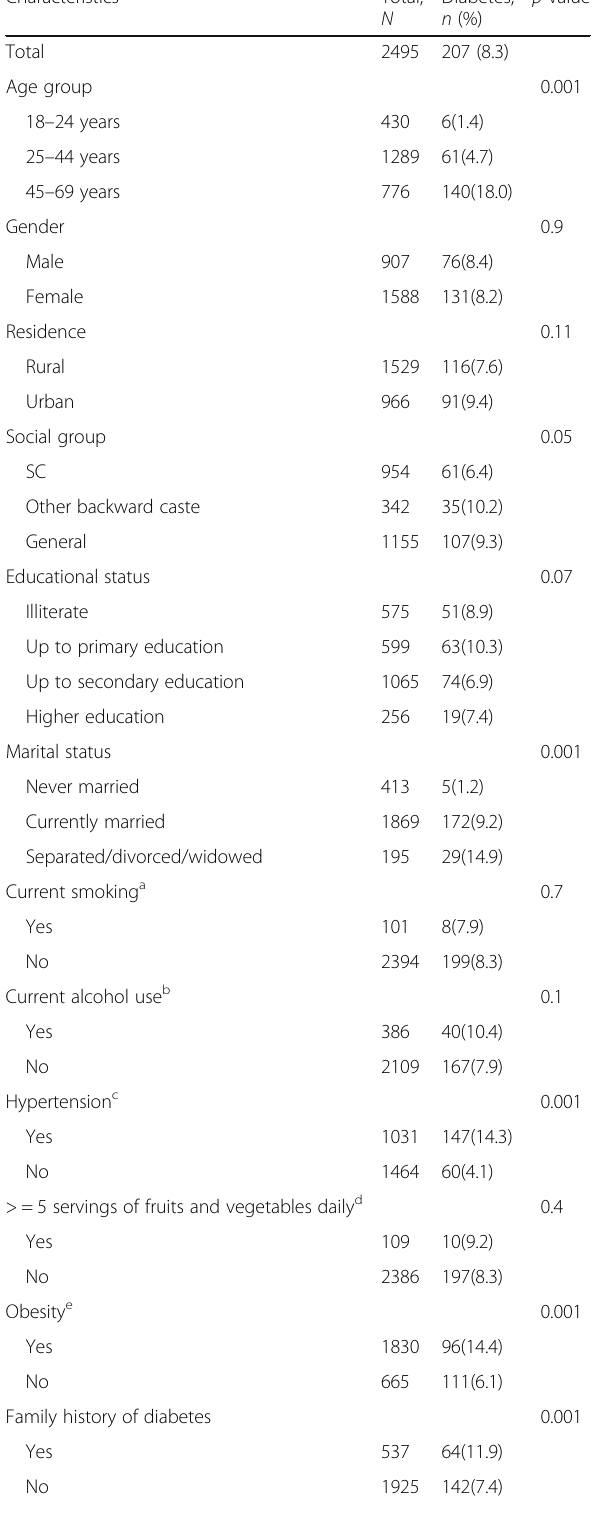
Table 1 Characteristics of study participants and the prevalence of diabetes by sociodemographic and clinical factors Characteristics